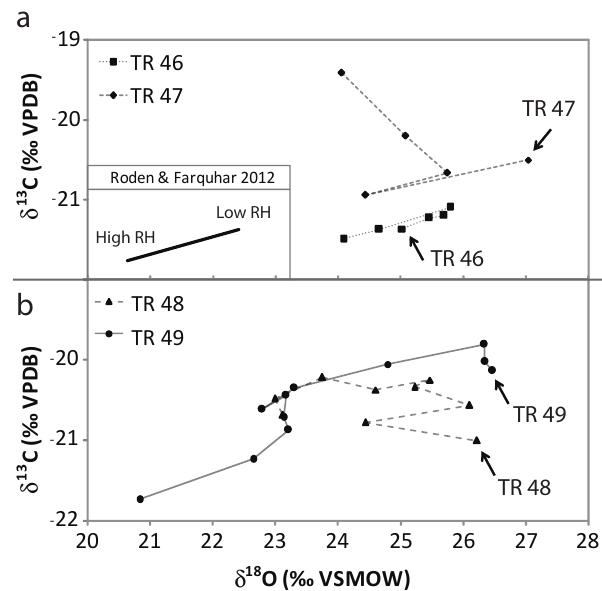
Figure 2. Scatterplots of dual-isotope data for four tree rings (TR 46–49), showing trends of δ 18 O and δ 13 C within a growing sea- son. Arrows point to the start of each numbered tree ring (ear- lywood), lines connect to consecutive samples (latewood) within each tree ring. Upper graph contains first two tree rings, and lower graph the third and fourth rings. Inset box in upper graph shows average low to high RH for Pinus radiata D. Don (after Roden and Farquhar, 2012). Low-to-high RH dual-isotope relationship: [ δ 13 C = 0.22 × δ 18 O–31.31]. Scale is the same for inset graph, but actual values of Roden and Farquhar (2012; δ 18 O low RH = 29.26‰, δ 18 O high RH = 26.9‰; δ 13 C low RH =− 24.86‰, δ 13 C high RH =− 25.38‰) do not correspond with these